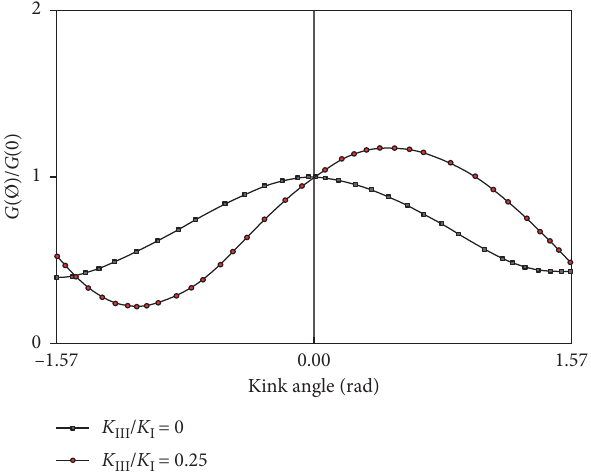
Figure 13: G ( ϕ ) / G ( 0 ) along with the change of kink angle ϕ